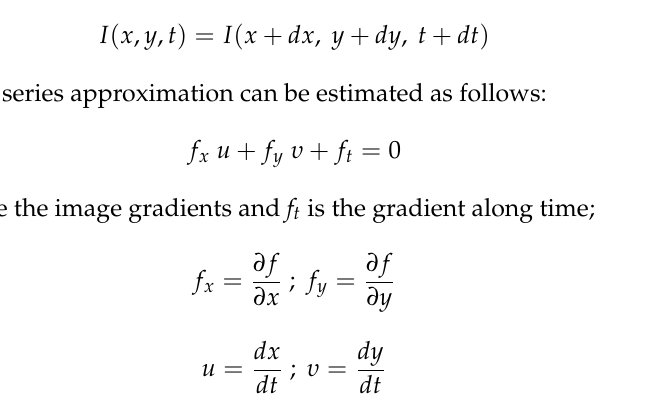
Figure 2. It is assumed that the intensity of the pixels is the same, and the pixels should satisfy the following equation.